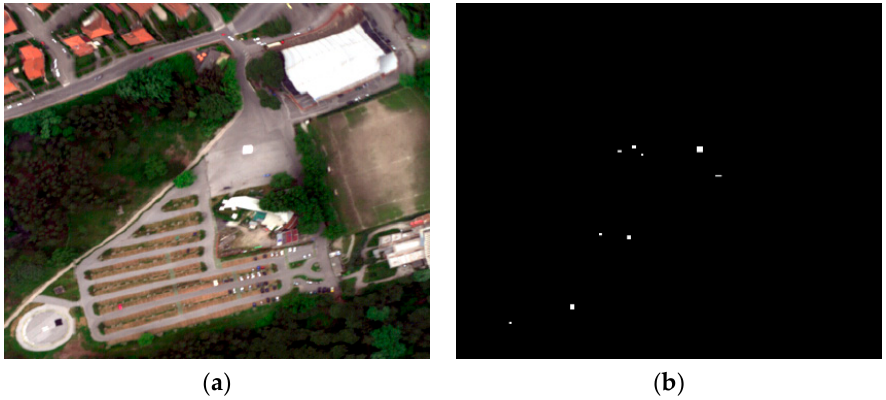
Figure 7. Viareggio dataset: ( a ) RGB image of the scene (R:219, G:144, B:66); ( b ) the ground-truth map.